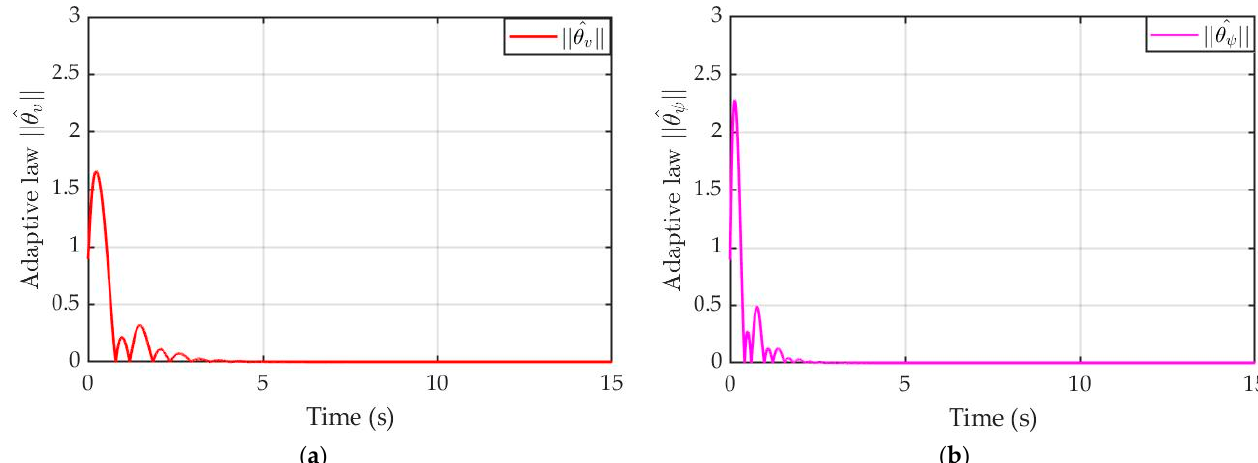
θ θ ˆ ˆ θ θ ˆ ˆ ; ( b ) ψ . Figure 11. Adaptive law: ( a ) (cid:107) ˆ θ v (cid:107) ; ( b ) (cid:107) ˆ θ ψ (cid:107) ; ( b ) ψ . v v